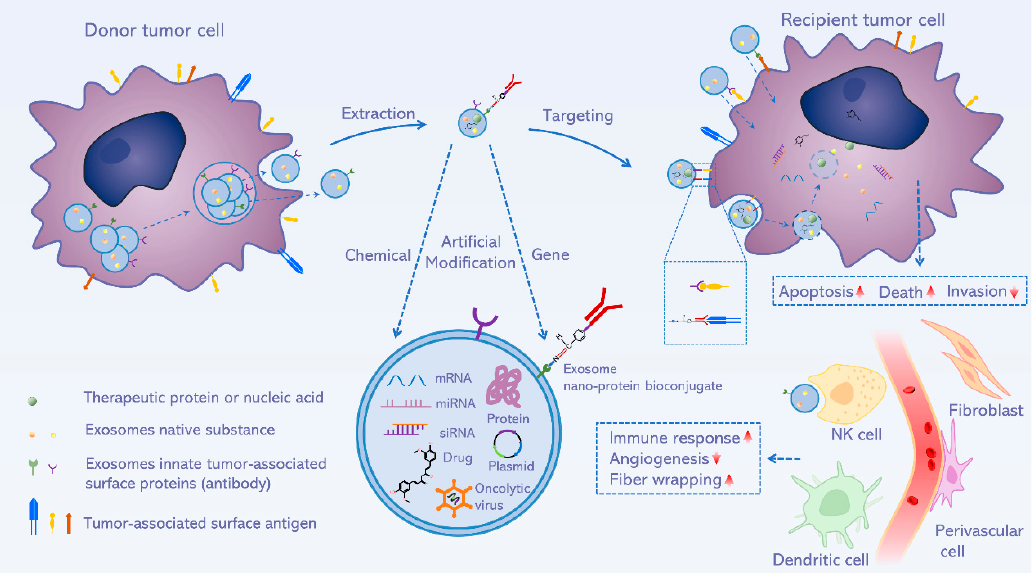
Figure 3. Schematic illustration of the tumor-derived exosomes with modification strategies for en- hancing targeting. A chemical or gene modification of extracted exosomes from tumor cells may further promote the anti-tumor functions from indicated concepts. further promote the anti-tumor functions from indicated concepts.